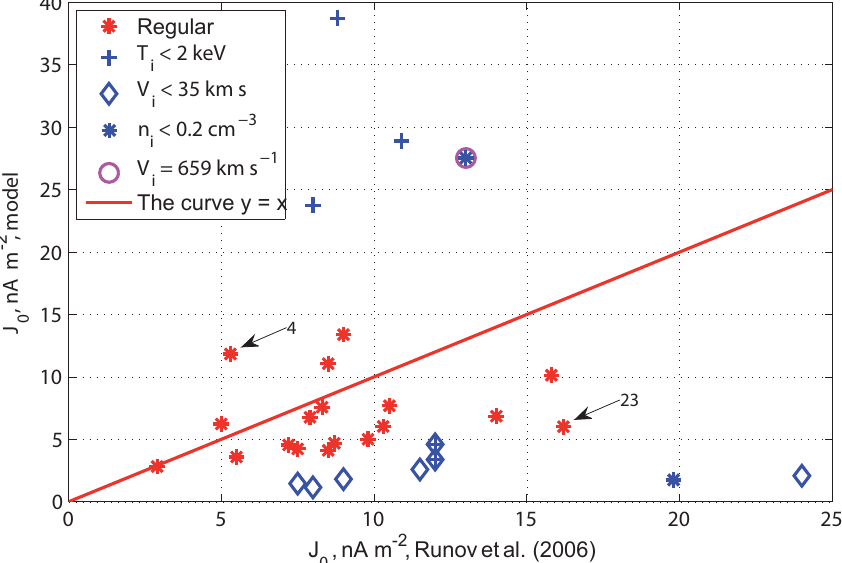
Figure 11. Typical current density J 0 of the analytical model vs. peaking perpendicular current density from Fig.2 of Runov et al. (2006). Blue crosses show cases of the lowest ion temperature, T i < 2keV (8,9,12,13,14 in Table1 of Runov et al. (2006)); blue diamonds show cases of the lowest ion drift velocity, V i < 35kms − 1 (8,9,10,19,21,29,30); and blue asterisks show cases (20,24) of the lowest ion number density, n i < 0 . 2cm − 3 . Magenta circle shows the case 20 of extremely high velocity, V i = 659kms − 1 . All other “regular” cases are shown by red asterisks. The red line plots y = x . Black arrows mark cases 4 and 23, demonstrating the largest (amongst red points) discrepancy of the observed and model